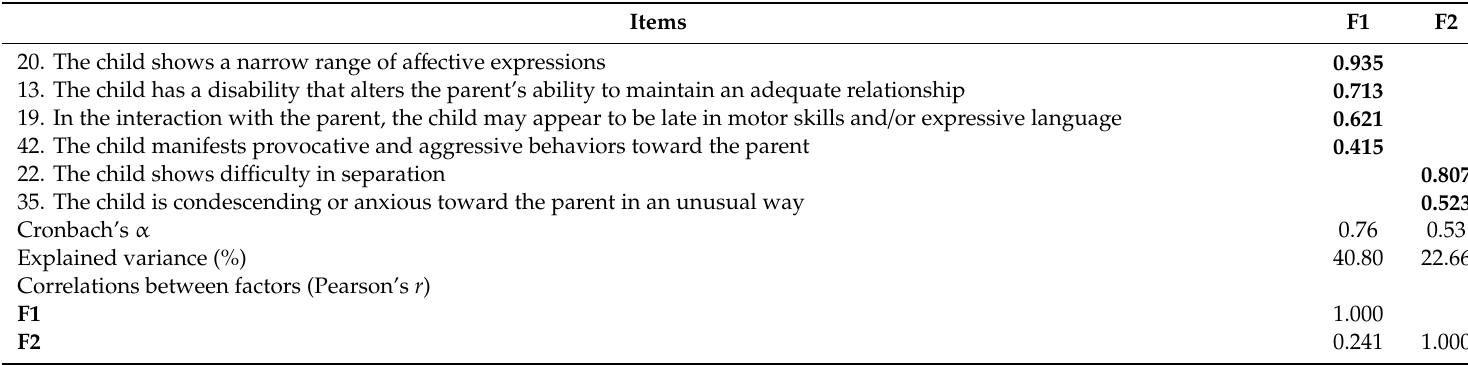
Table 3. “Child” Area Exploratory Factor Analysis and Correlation Matrix between